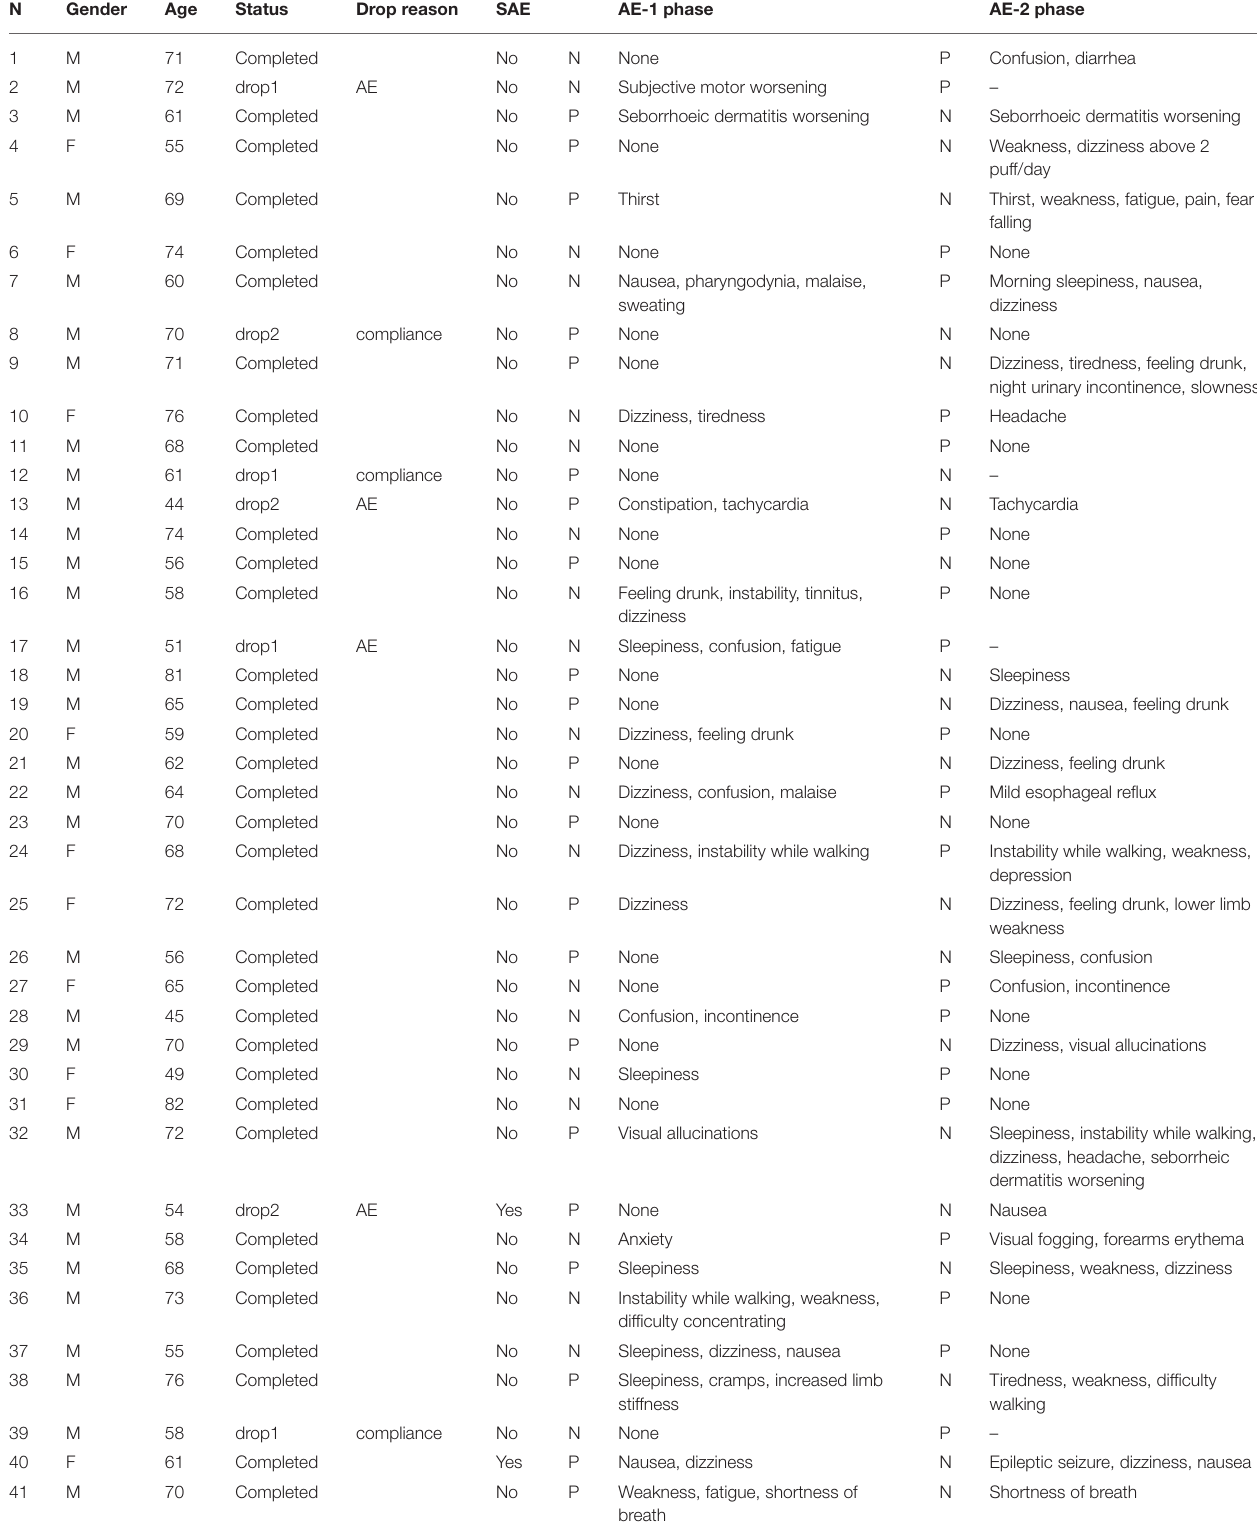
TABLE 2 | Complete list of adverse